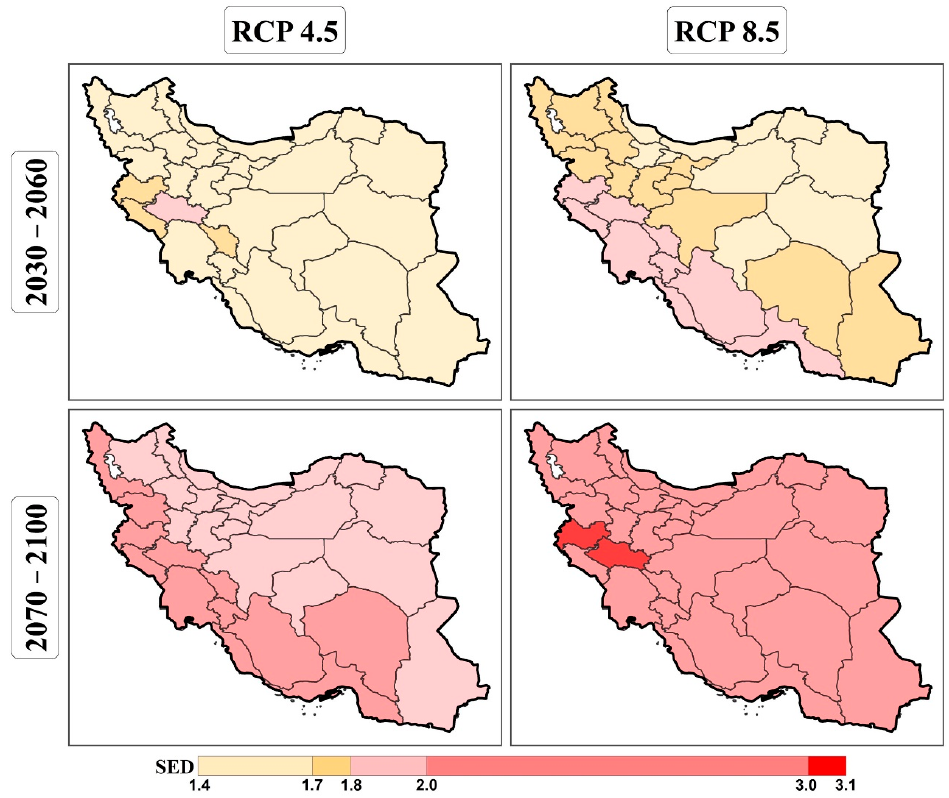
Figure 6. SED variations over all 31 provinces of Iran for RCP4.5 and RCP8.5 during 2030–2060 and 2070–2100 periods. Unitless.